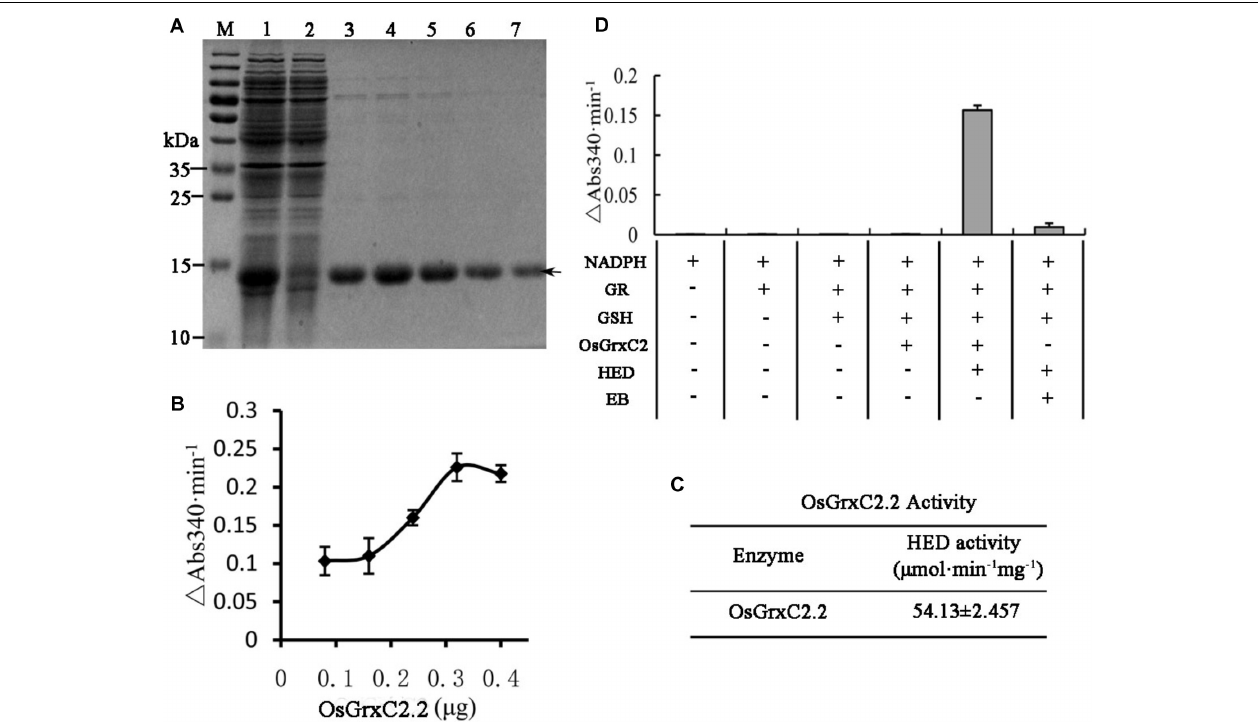
FIGURE 2 | Expression, purification, and enzymatic characterization of OsGrxC2.2. (A) Expression and purification of recombinant OsGrxC2.2 in E. coli. Fifteen microliters of each fraction was loaded into each lane of a 15% SDS-PAGE gel, followed by Coomassie brilliant blue R-250 staining. Lane 1, crude extracts from E. coli expressing OsGrxC2.2; lane 2, flow-through proteins from the Ni-NTA column; lanes 3–7, OsGrxC2.2 eluted from the Ni-NTA column. Molecular masses (in kDa) of standards are shown on the left. The arrow indicates the target protein. (B) Determination of OsGrxC2.2 protein enzymatic activity followed by NADPH oxidation rate. NADPH oxidation was monitored at 340 nm in a 100 µ L reaction mixture containing 0.1 M Tris-HCl (pH 7.4), 0.6 µ g GR, 0.75 mM HED, 0.2 mM NADPH, and OsGrxC2.2 at concentrations varying from 0.06 to 0.3 µ g. The rate of NADPH oxidation is shown by (cid:77) Abs340min − 1 . (C) Enzymatic activity of OsGrxC2.2. (D) Effects of various combinations of GR, GSH, HED, EB (elution buffer), and OsGrxC2.2 on the initial rates of NADPH oxidation.